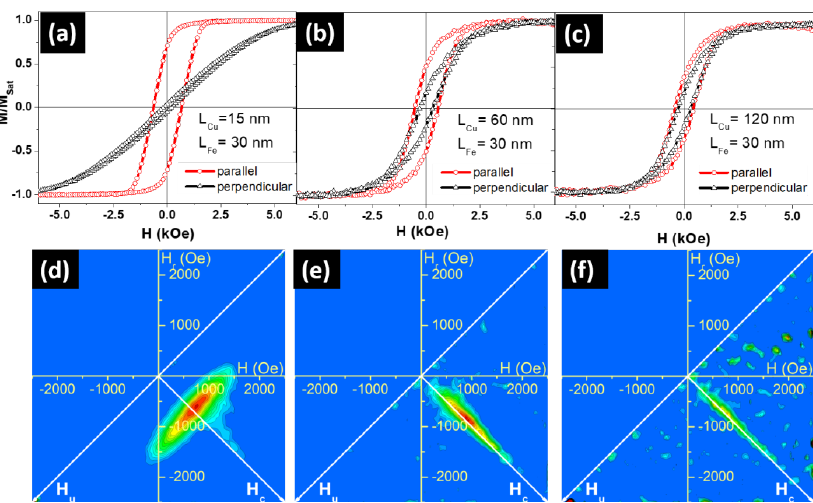
Figure 3. Hysteresis loops of multi-segmented Fe/Cu NWs when the external magnetic field was applied parallel (in red) and perpendicular (in black) to the NW long axis and for L Cu ( a ) 15 nm, ( b ) 60 nm, and ( c ) 120 nm. Their related first-order reversal curve (FORC) diagrams when the external magnetic field was applied parallel to the NWs’ long axis and for L Cu ( d ) 15 nm, ( e ) 60 nm, and ( f ) 120